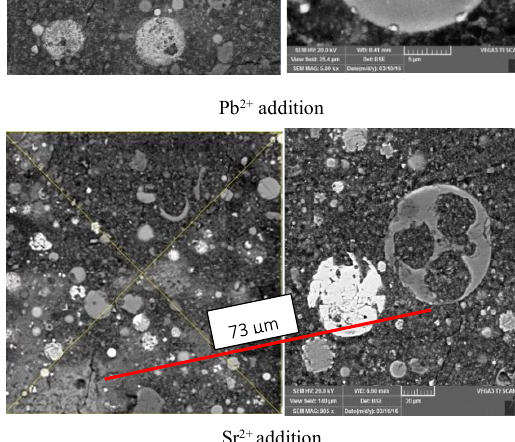
Figure 7. Microstructure of geopolymer with different metal